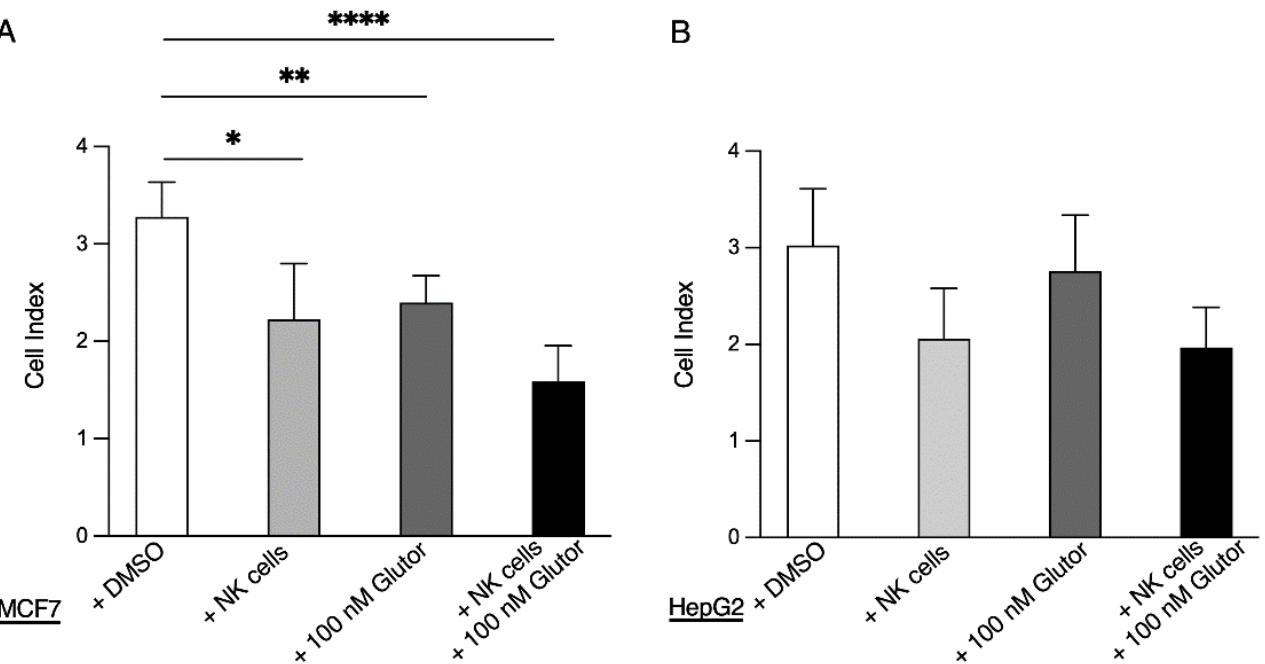
Figure 2. The effect of Glutor on NK cells and tumor cells. Impedance-based analysis of MCF7 cells ( A ) and HepG2 cells ( B ) in the presence or absence of 0.375 × 10 4 pre-activated NK cells, 100 nM Glutor or 0.375 × 10 4 pre-activated NK cells + 100 nM Glutor. The cell index at 72 h after addition of pre-activated NK cells +/ − Glutor is shown: n = 3. Data were pooled from three independent ex-